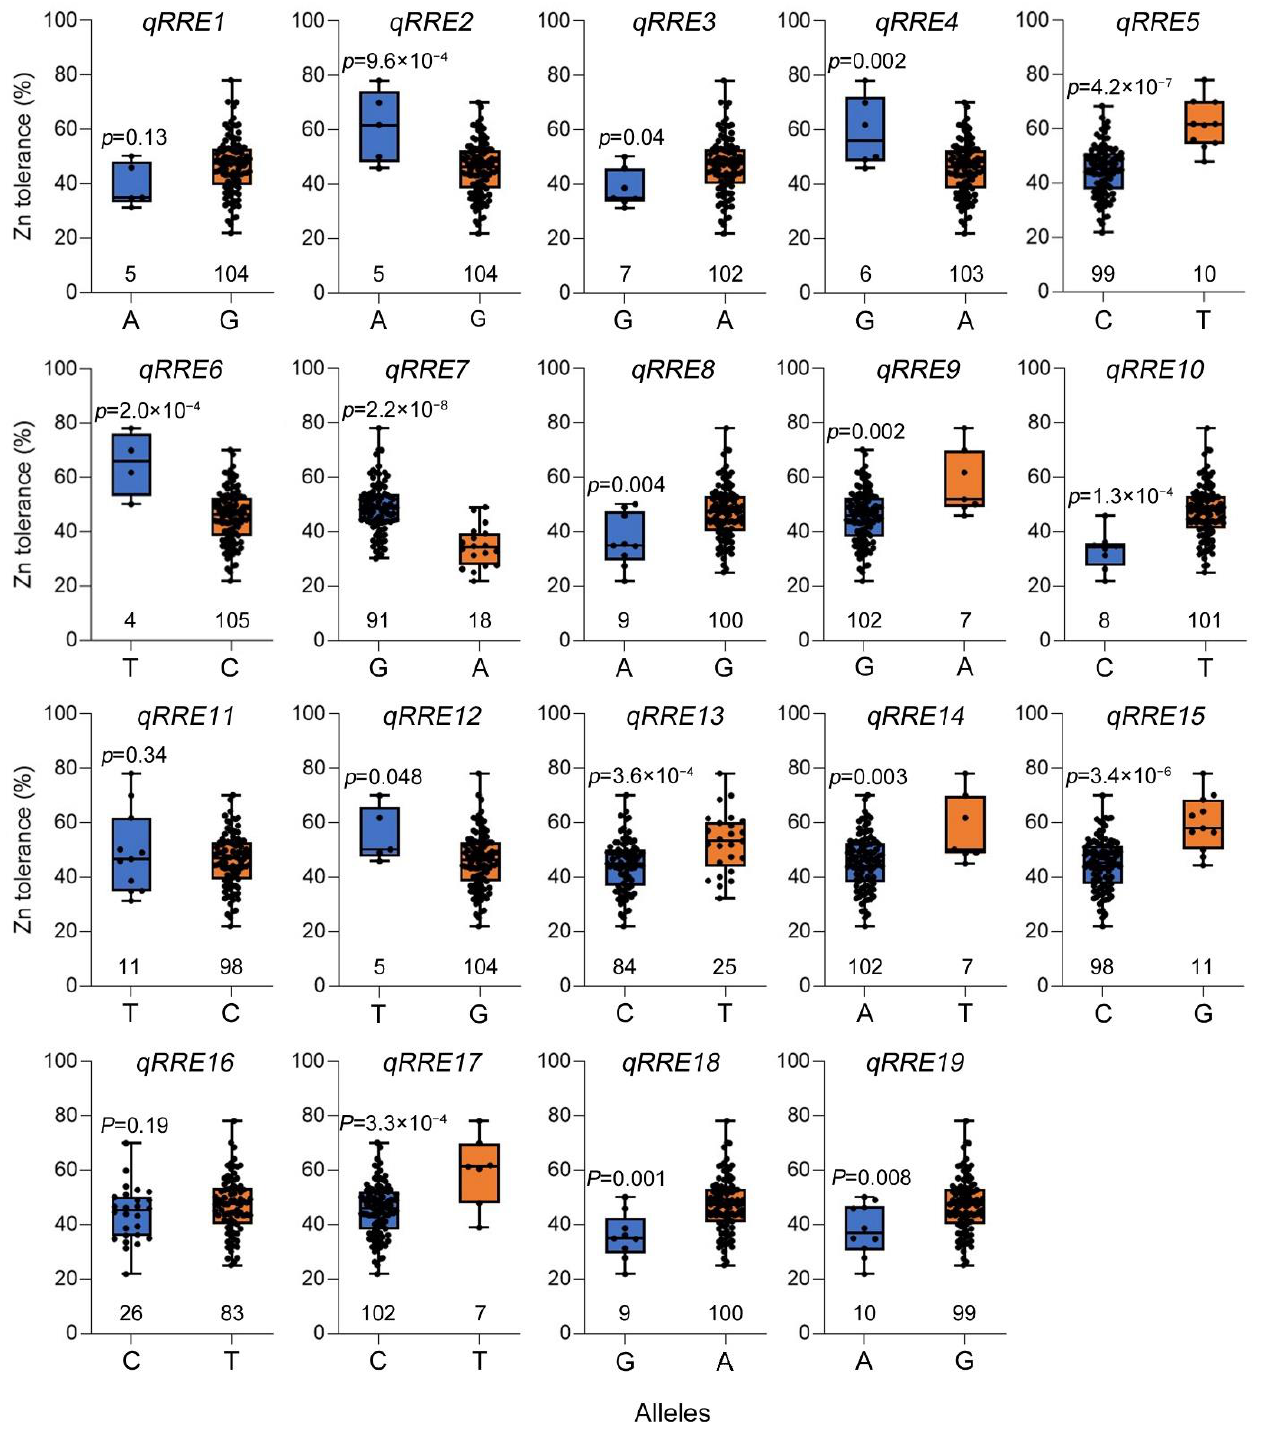
Figure 3. Effect analysis of allelic variations on relative root elongation under high Zn toxicity.